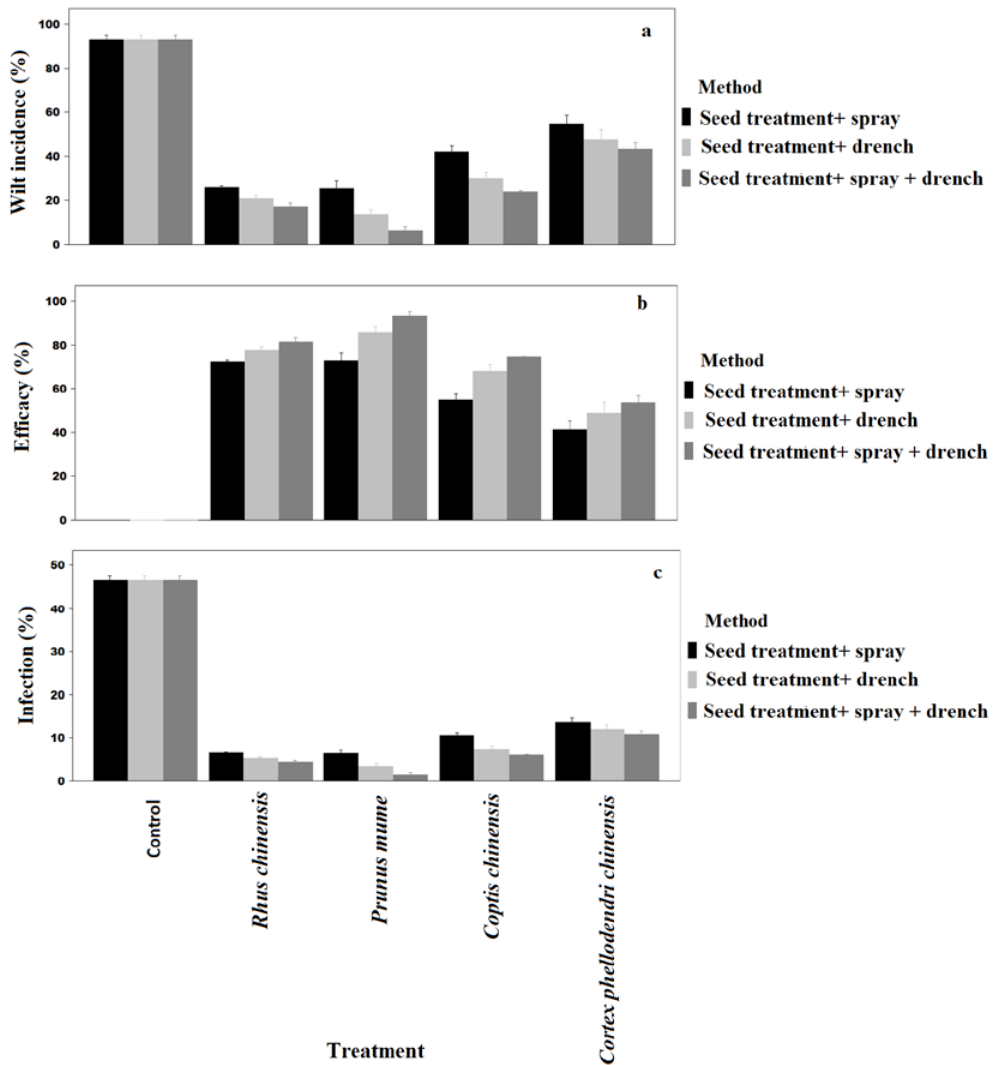
Figure 3. Mean wilt incidence (a), efficacy (b) and infection percentage (c) of susceptible cotton germplasm treated with extracts from four Chinese medicinal herbs applied with three different treatment methods, under greenhouse